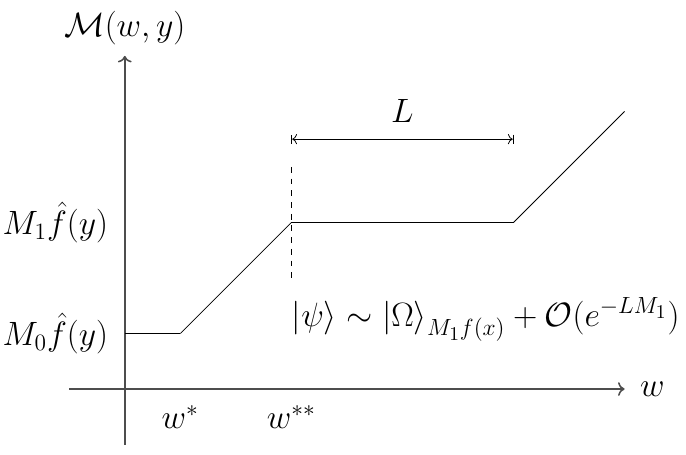
Figure 4 . The modified profile of the ( d + 2) -dimensional mass matrix M ( w, y ) . Only the w > 0 region is shown. The asymptotic behavior at w → ∞ is unchanged, but there is a plateau of length L along which M ( w, y ) = M 1 ˆ f ( y ) does not depend on w . Due to the plateau, the quantum